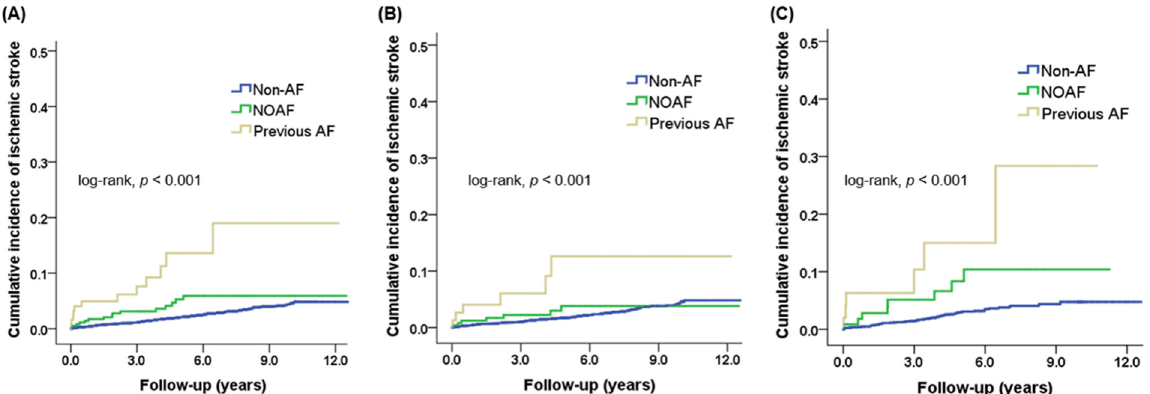
Figure 3. Kaplan–Meier curves for the cumulative incidence of ischemic stroke after acute myocardial infarction according to onset time of atrial fibrillation in ( A ) the overall population, ( B ) men, and ( C ) women.